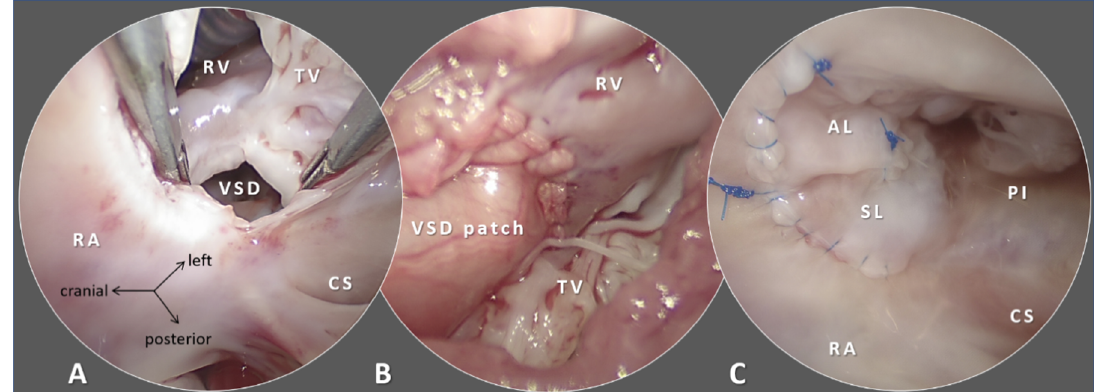
Figure 2. Intraoperative endoscopic images of ventricular septal defect (VSD) patch closure during repair of tetralogy of Fallot. ( A ) The septal leaflet (SL) of the tricuspid valve (TV) is detached and retracted and the VSD is assessed. The defect has fibrous ridges. ( B ) Left ventricle to aorta tunnel is completed by autologous pericardium patch, thus the VSD is closed (transventricular view). ( C ) The detached tricuspid leaflets are reattached to annulus and commissuroplasty is performed. Abbreviations: AL: anterior leaflet of the tricuspid valve; CS: coronary sinus; PI: posteroinferior leaflet of the tricuspid valve; RA: right atrium; RV: right ventricle; SL: septal leaflet of the tricuspid valve; TV: tricuspid valve.